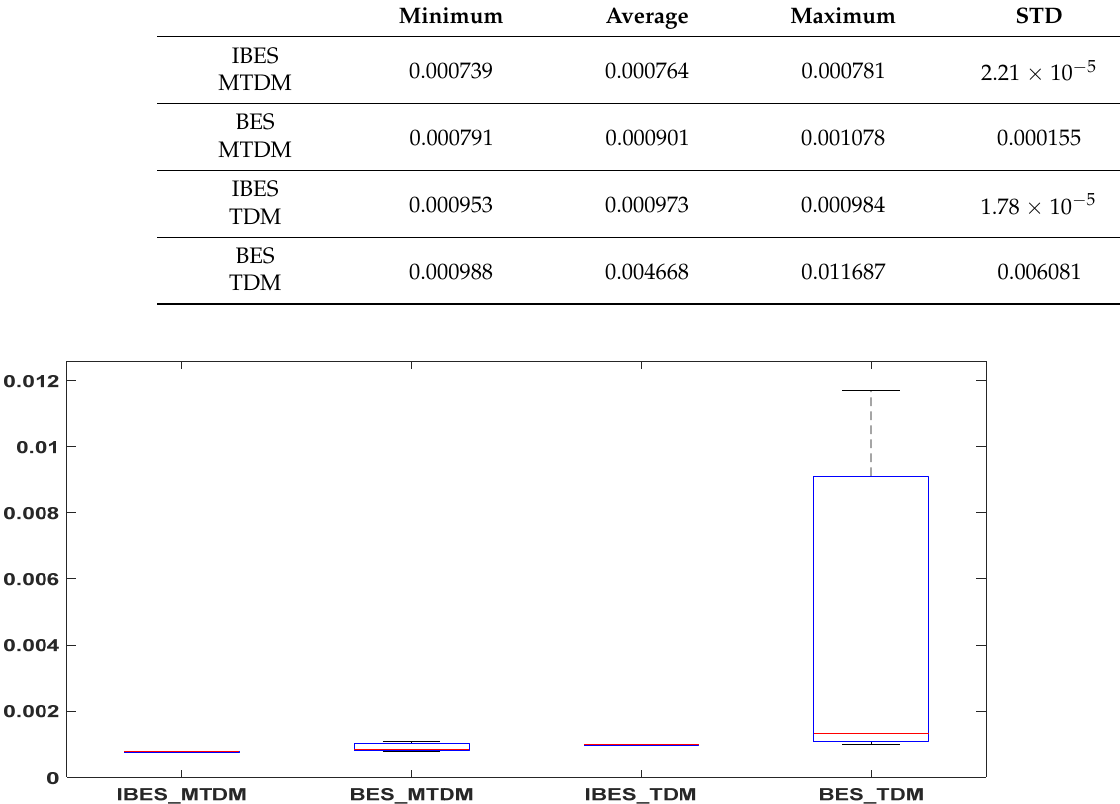
Figure 15. Boxplot for the IBES applied to the MTDM and TDM and the BES applied to the MTDM and TDM for 30 independent runs.